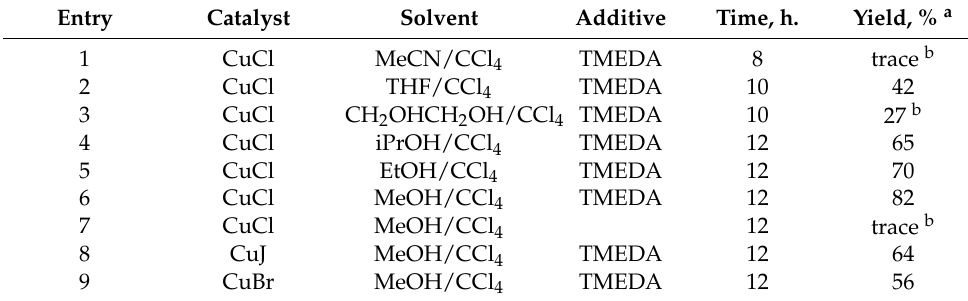
Table 1. Optimization of catalyst and solvent effect.